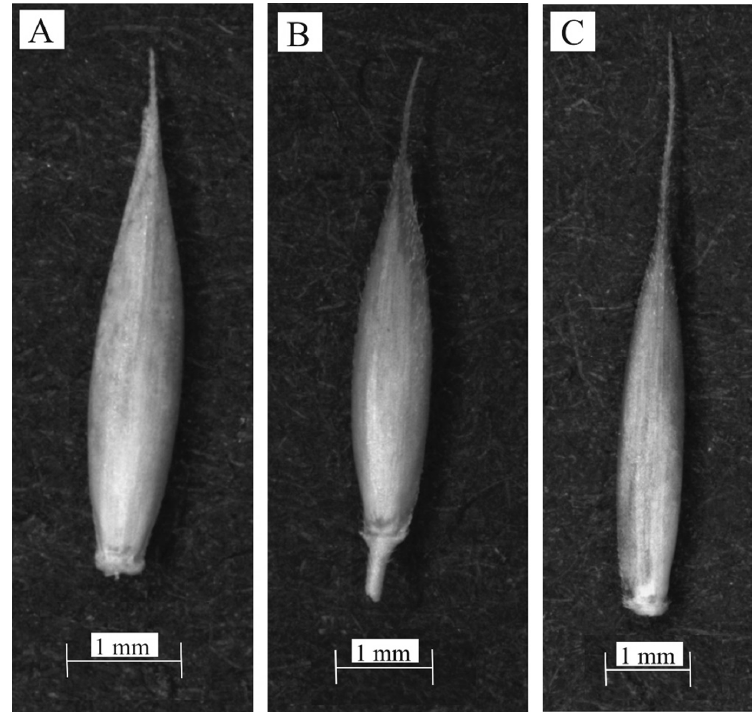
Figure 2. Tipycal lemma of F. vaginata ( A ), F. pseudovaginata ( B ) and F. tomanii ( C ).